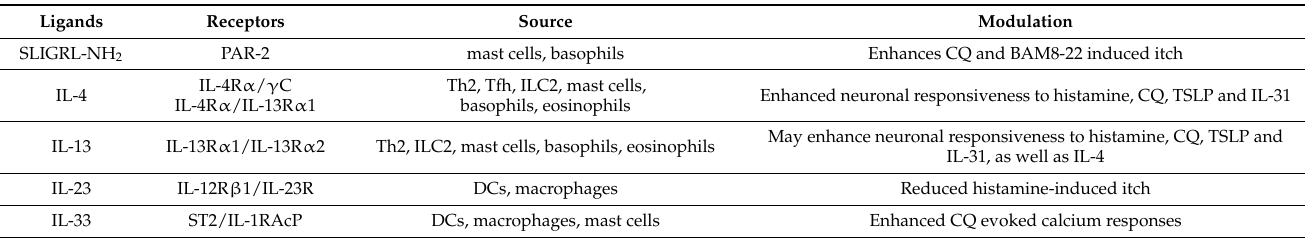
Table 2. Itch modulators from immune